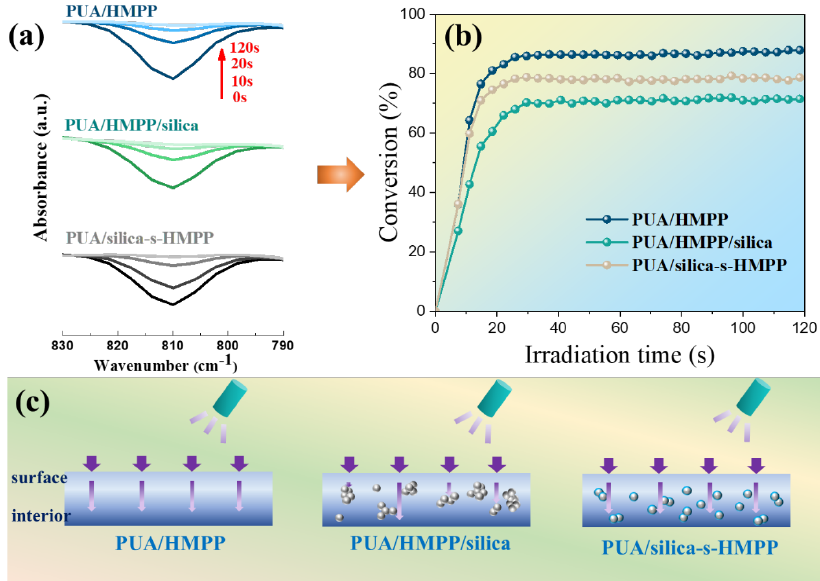
Figure 3. ( a ) Real-time FTIR curves of the photopolymerization of three samples, ( b ) Conversion vs. irradiation time plots for the UV-curable samples and ( c ) Illustration of the photopolymerization process of the three